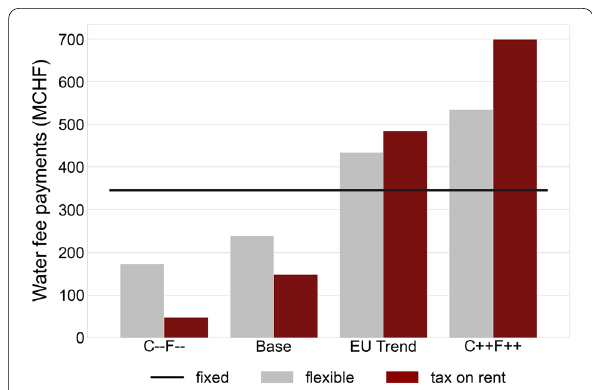
Fig. 6 Revenues from water fees for different scenarios 2025. Note : As described in Sect. 2.2, our sample covers only around 63% of